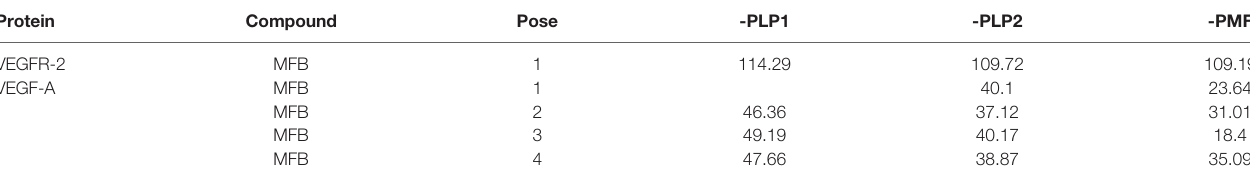
TABLE 1 | Scoring functions of MFB with VEGF-A and VEGFR-2.